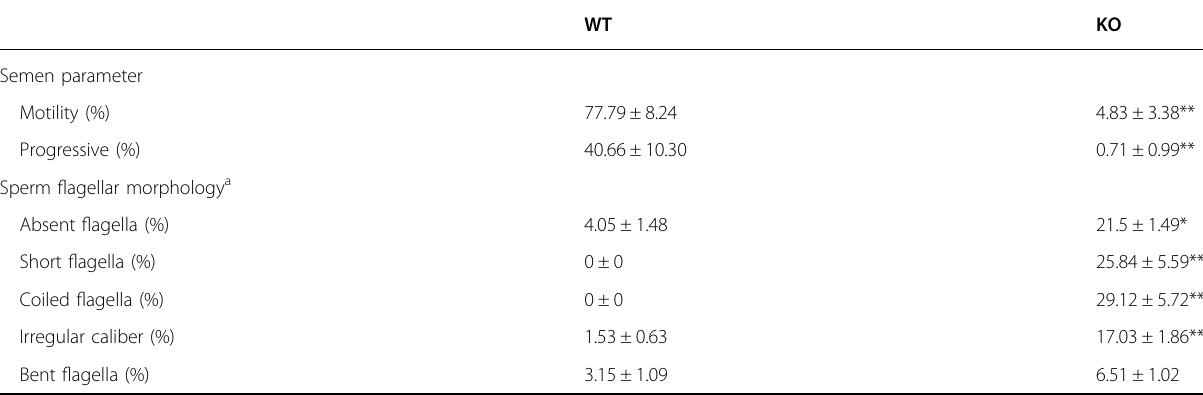
Table 2 Sperm characteristics and fl agellar morphology of Wdr63-KO male